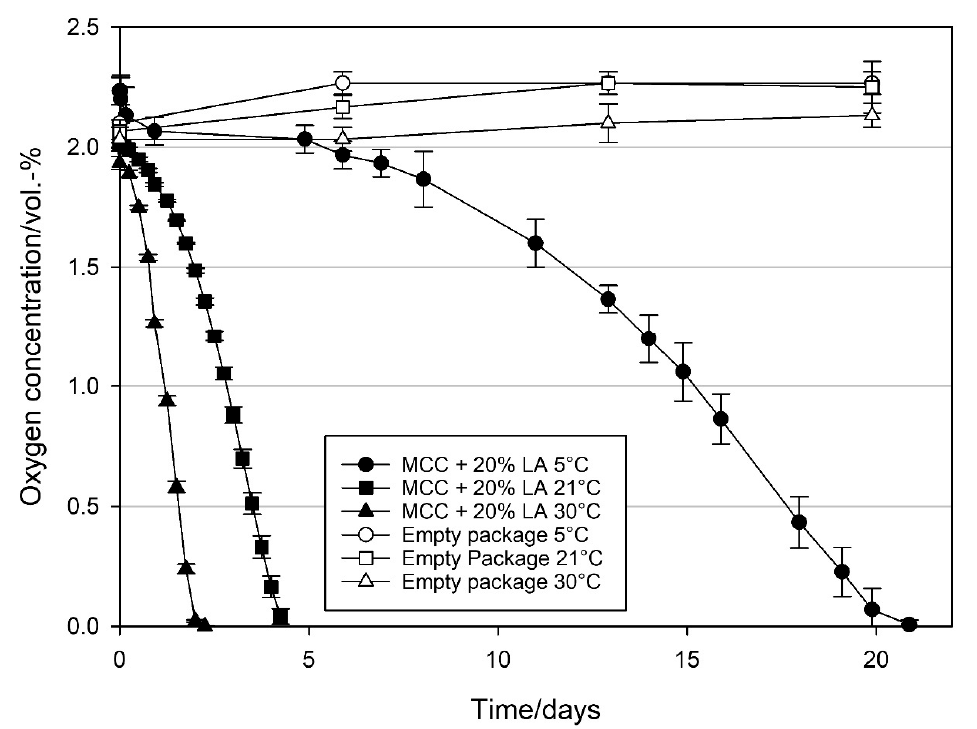
Figure 6. Oxygen concentration in packages containing 1 g modified calcium carbonate (MCC) loaded with 20 wt% linoleic acid stored at 5, 21, and 30 °C, and ~50% RH in the package and of empty packages stored under the same conditions. Packed under modified atmosphere (MAP, 2 vol.-% O 2 , rest N 2 ; headspace 250 mL). Mean values and standard deviation (n = 3).